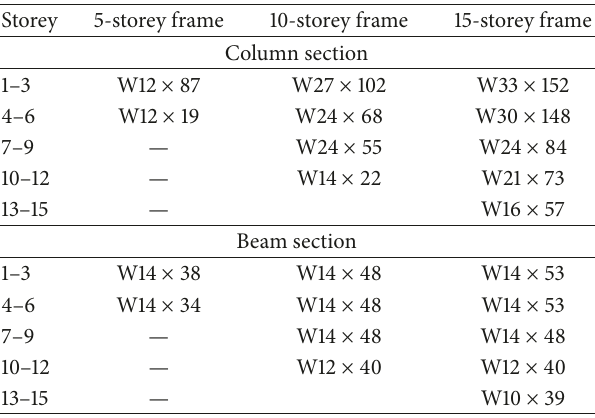
Table 2: Sectional properties of 5-, 10-, and 15-storey